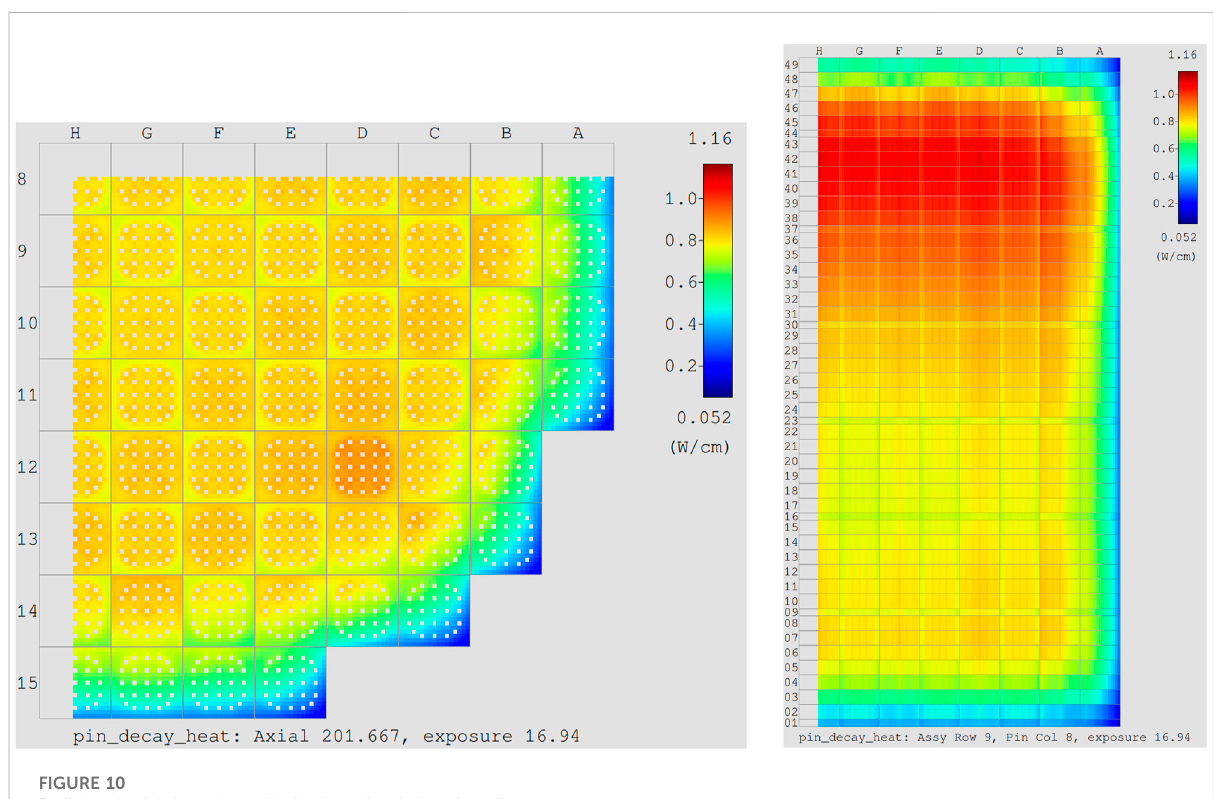
FIGURE 10 Radial and axial decay heat distribution after 1 day of